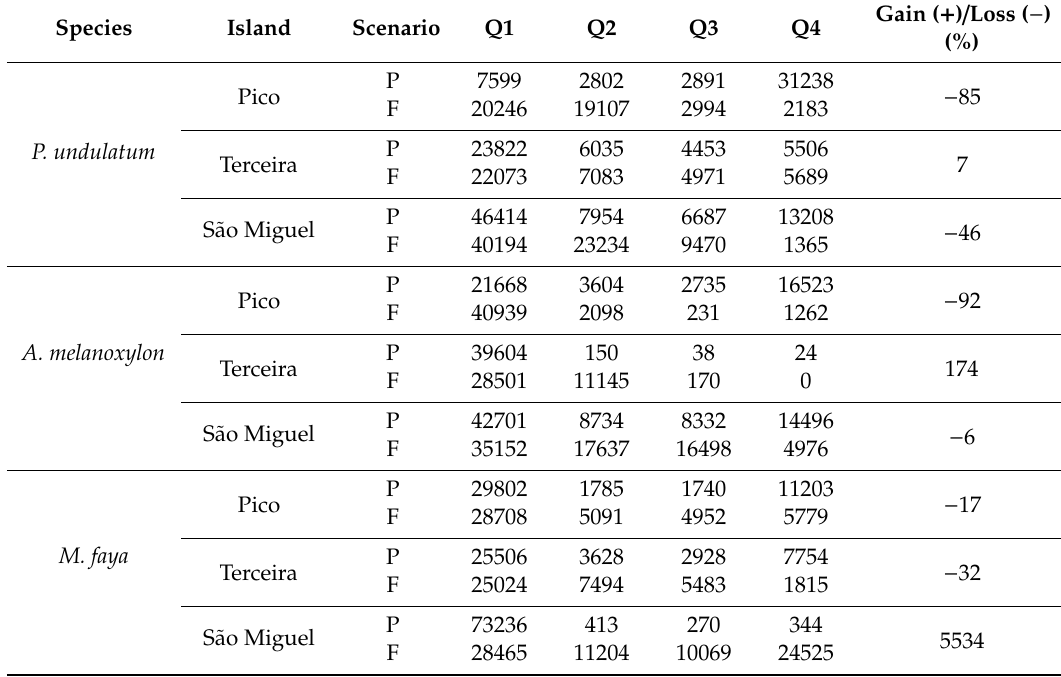
Table 5. Values of respective quartiles for habitat suitability maps: P. undulatum , A. melanoxylon, and M. faya based on the EGV set 2. Table shows the percentage of projected habitat space gain ( + ) / loss (-). P: Present; F: